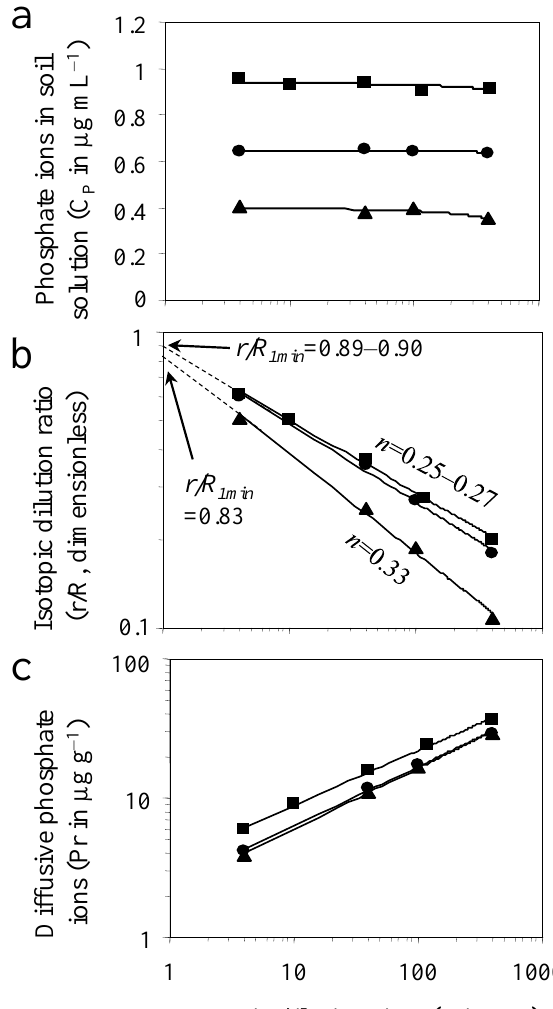
Fig. A1. Concentration of phosphate ions in soil solution (C P in a ), isotopic dilution ratio ( r/R in b ) and diffusive phosphate ions (Pr in c ) as a function of isotopic dilution time. Example for the A + AE soil horizon of plot 1. The different symbols represent the different soil sub-replicates or zones. No time dependence of C P in ( a) (lin- ear regression: P> 0 . 05). Adjustment of Eq. (5) in ( b) : r 2 > 0 . 994; P< 0 . 0001. Adjustment of Eq. (6) in ( c) : r 2 > 0 . 998; P< 0 . 0001. Mean concentrations of phosphate ions in soil solution and param- eters of Eqs. (5) and (6) are given in Table